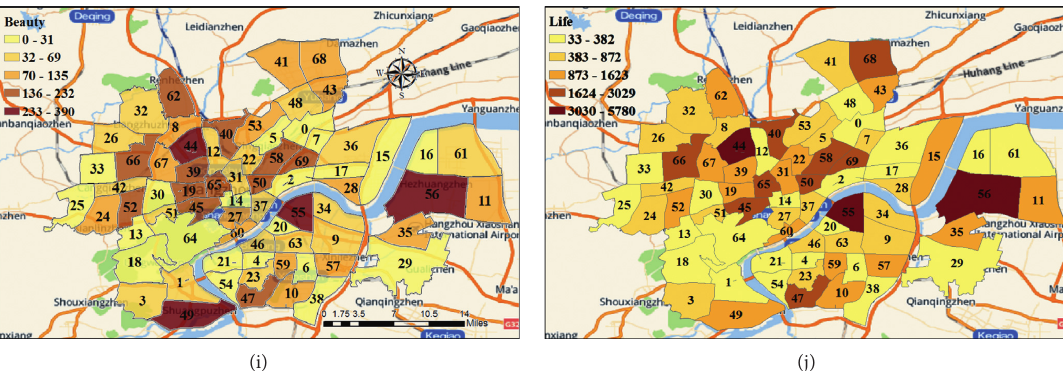
Figure 4: Zonal distribution of POIs in Hangzhou, China. (a) Medicines. (b) Shopping. (c) Restaurant. (d) Education. (e) Enterprise.